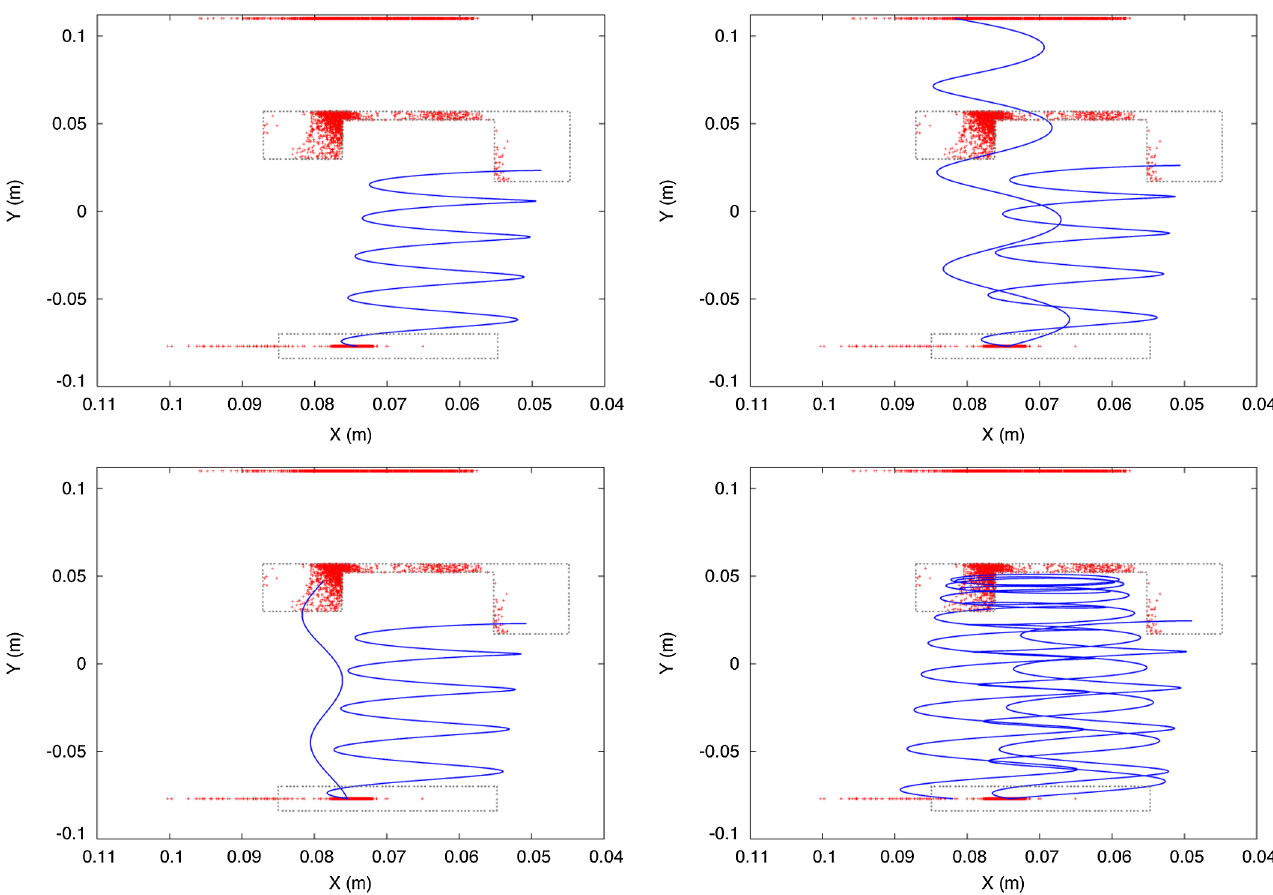
FIG. 11. X - Y view of the impact distribution with four individual example electron trajectories: (top left) An electron that is absorbed on the first impact of the bottom surface, (top right) an electron that is reflected from the bottom surface and absorbed at the top surface, (bottom left) an electron that is reflected at the bottom surface and absorbed on the foil assembly, and (bottom right) an electron that is reflected from the bottom surface and then magnetically reflected by the field and finally absorbed at the bottom surface. The gray dashed line represents the foil assembly and electron catcher